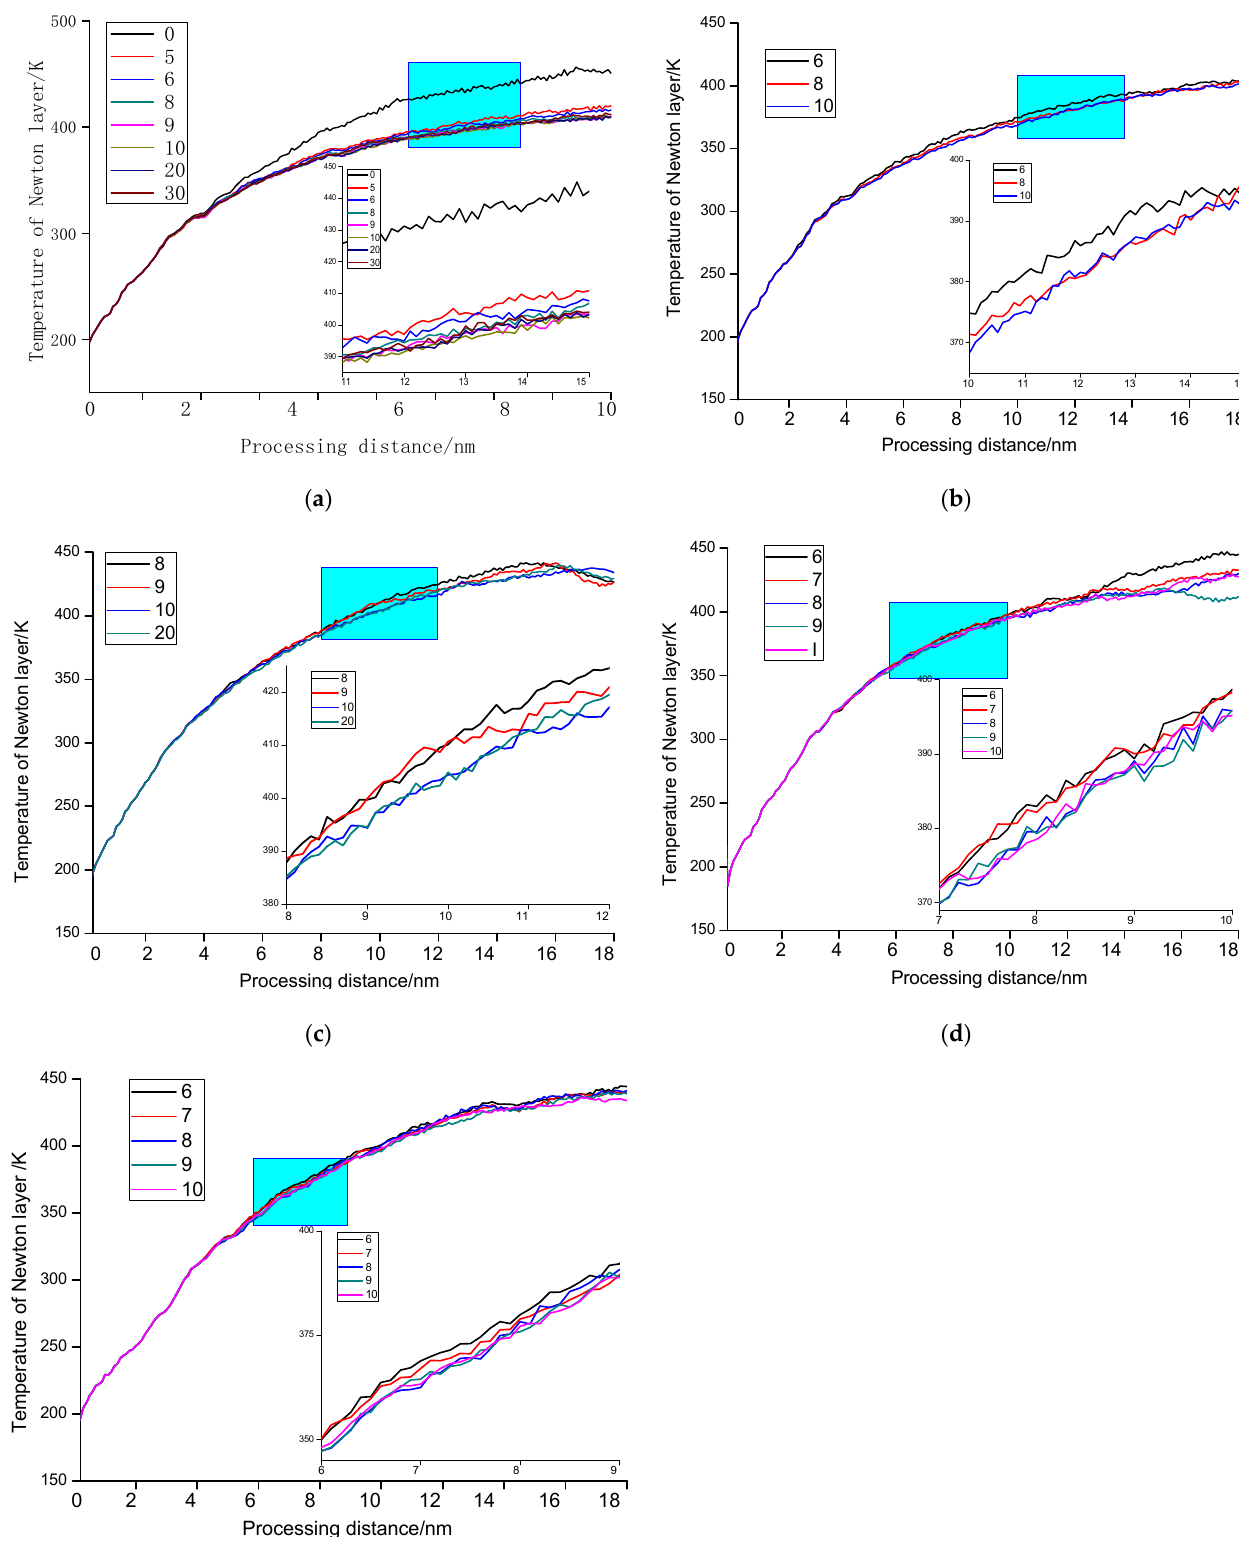
Figure 7. Effect of different tool clearance angles on workpiece temperature with a machining depth of 1 nm and a machining speed of 200 m/s ( a ) r = 0.5 nm, γ 0 = 10 ◦ ; ( b ) r = 0 nm, γ 0 = 10 ◦ ; ( c ) r = 1.5 nm, γ 0 = 10 ◦ ; ( d ) r = 0.5 nm, γ 0 = 0 ◦ ; ( e ) r = 0.5 nm, γ 0 = − 10 ◦